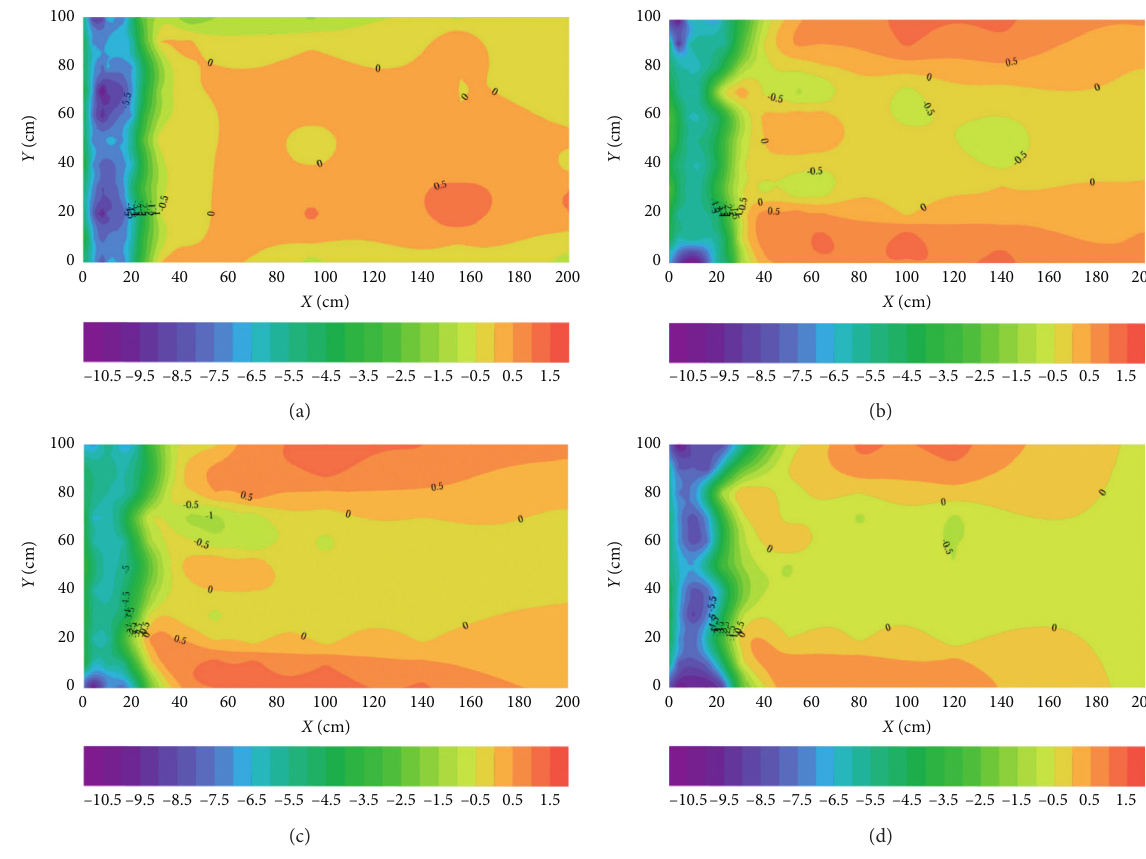
Figure 11: The bed topography for a chute with a semicircular block at a discharge of 15.5L/s and different divergence ratios of (a) 1, (b) 1.45, (c) 1.75, and (d)